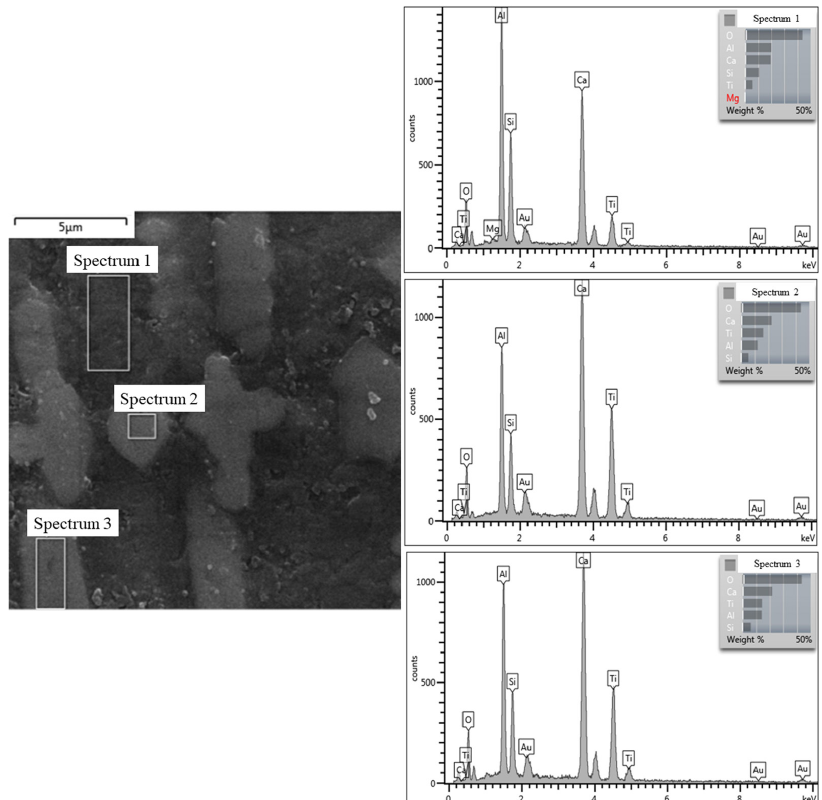
Figure 7. SEM and EDS analyses of glass-ceramic obtained from Ca Glass treated at 960 ºC during 6 hs. Three different regions were analyzed (spectrum 1, 2 and 3).